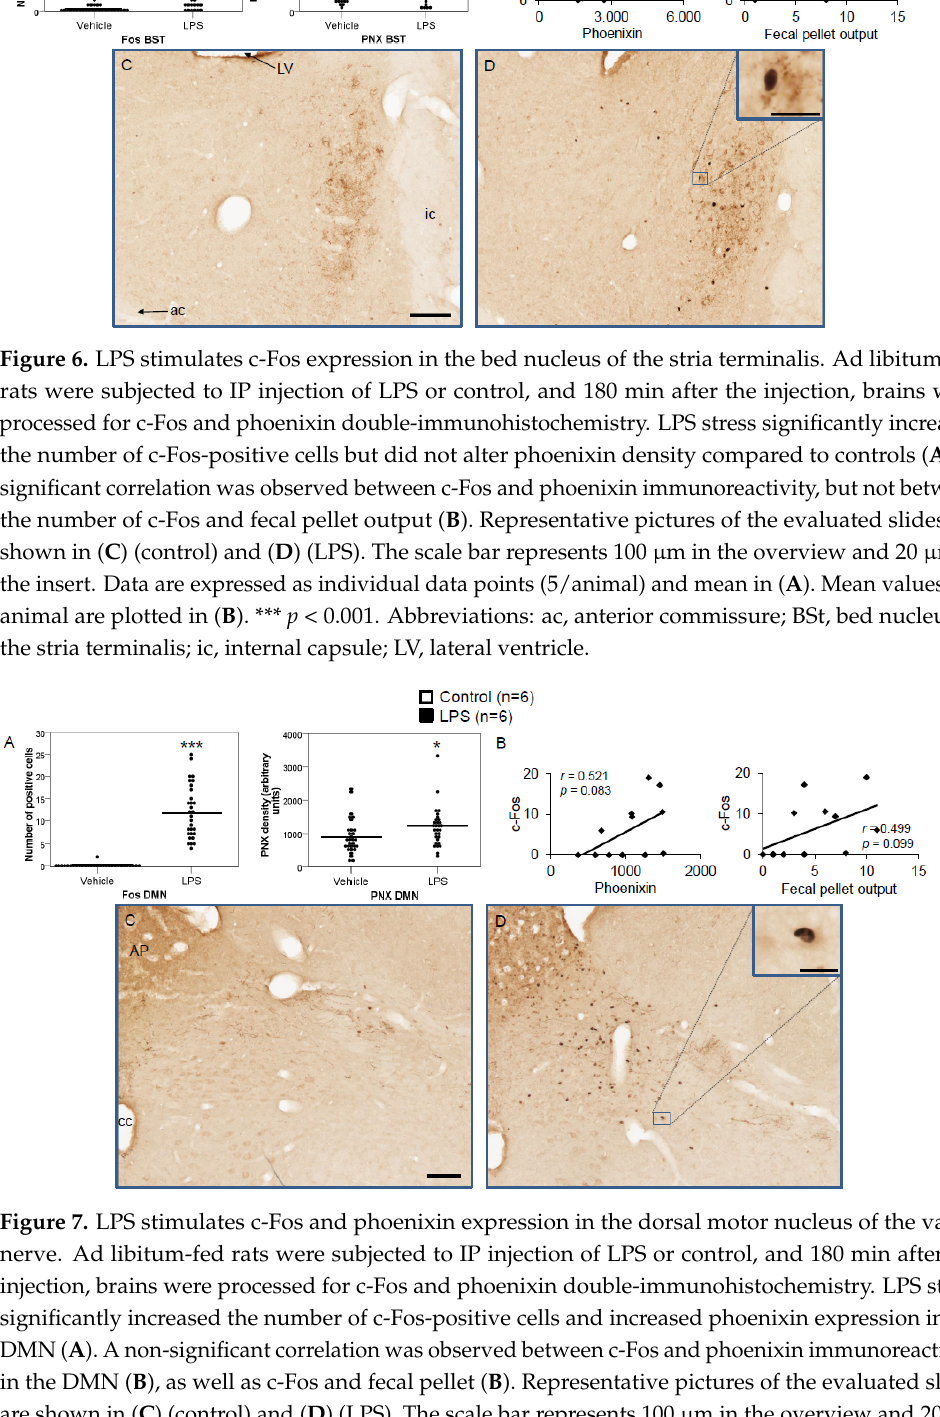
Figure 8. LPS stimulates c-Fos and phoenixin expression in the nucleus of the solitary tract. Ad libitum-fed rats were subjected to IP injection of LPS or control, and 180 min after the injection,